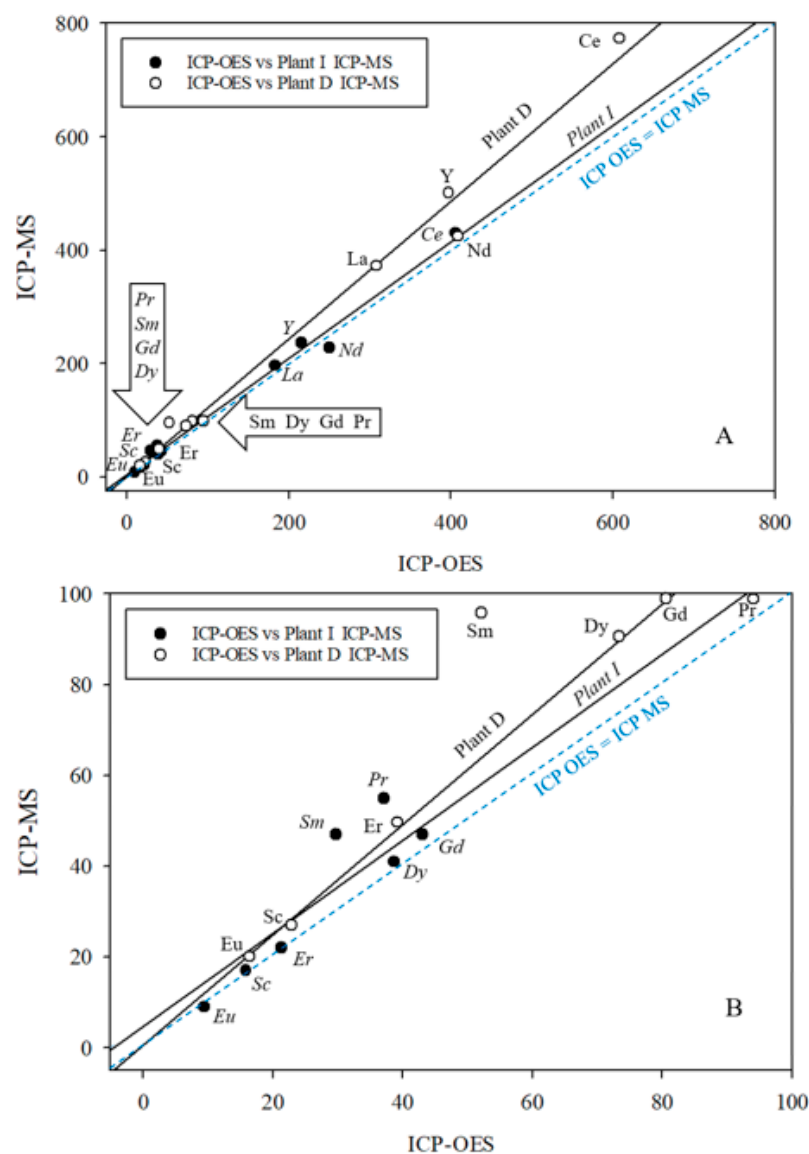
Figure 4. ( A ) Overall comparison of ICP-MS vs. ICP-OES for fly ashes from two power plants and ( B